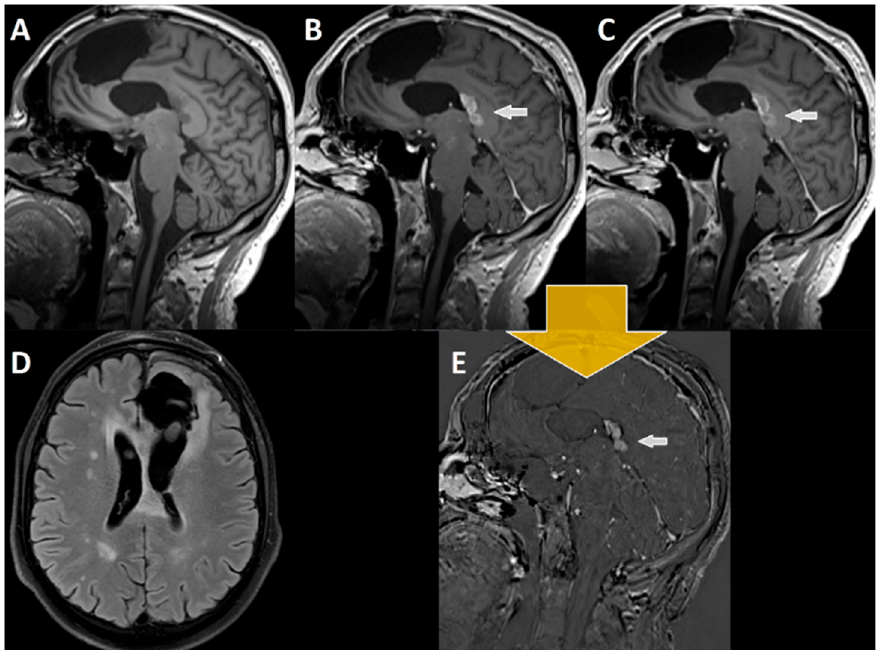
Figure 4. MRI imaging of a 52-year-old patient with glioblastoma, 7 months after resection and 4 months after RCT with discontinuation of adjuvant temozolomide therapy ( A ) T1-MPRAGE prior to i.v. administration of contrast agent, ( B ) early T1-MPRAGE 2 min after contrast administration, and ( C ) late T1-MPRAGE 20 min after contrast administration. ( D ) FLAIR sequence with the suspicious lesion in the corpus callosum. The white arrow in ( B , C , E ) points towards the contrast enhancing lesion suspicious of tumor recurrence. Subtraction of late (20 min, ( C )) from early enhancement (2 min, ( B )) T1-MPRAGE results (yellow arrow) in ( E ), where a “wash out” of contrast agent can be seen ( B – C = E ). Therefore, this lesion was retrospectively considered tumor tissue, which again was confirmed by postoperatively performed histopathological analyses.